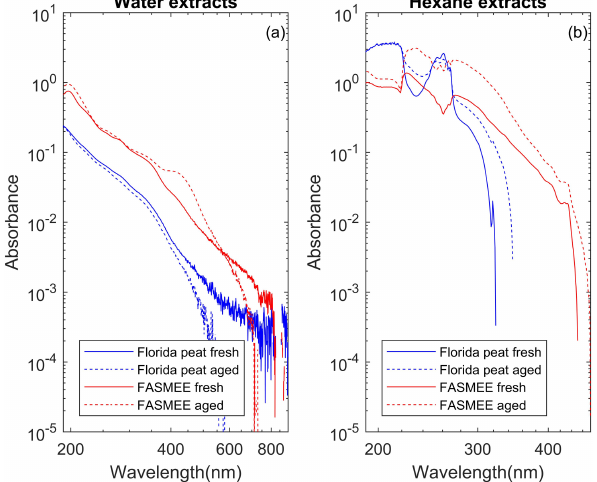
Figure 2. Light absorbance spectra of water (a) and hexane (b) ex- tracts from representative samples of biomass-burning emissions from two representative fuels. Solid and dashed lines correspond to fresh and aged BB emissions,